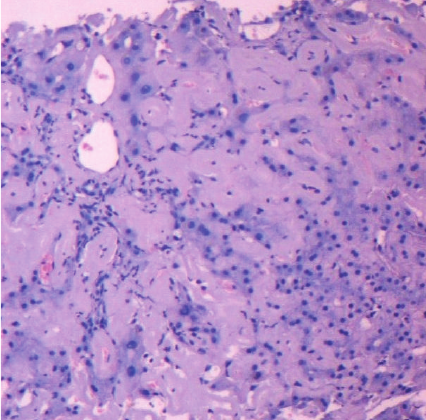
Figure 2: Extensive confluent accumulation of amyloid in perivas- cular portal tract fibrous tissue and in perisinusoidal space of Disse with associated atrophy of liver cell plates (Hematoxylin & Eosin, ×